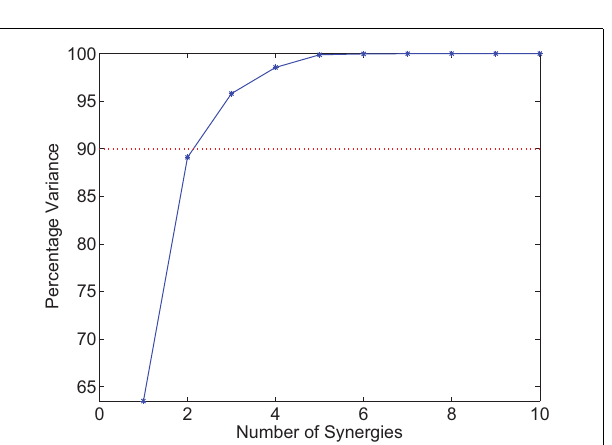
FIGURE 3 | Optimal inputs to the walker moment, electric motors, and stimulation channels to reproduce the optimal gait trajectories .